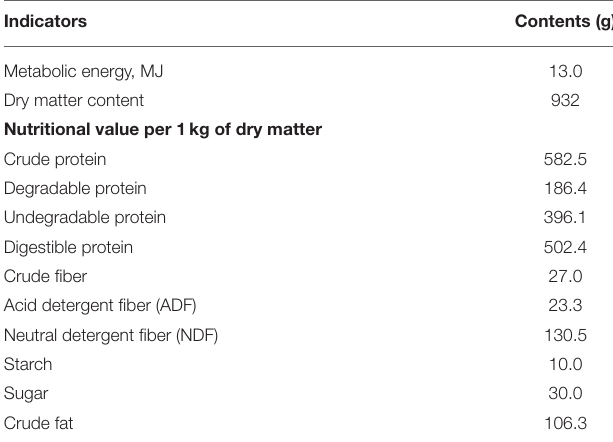
TABLE 2 | Nutritional value of protein concentrate